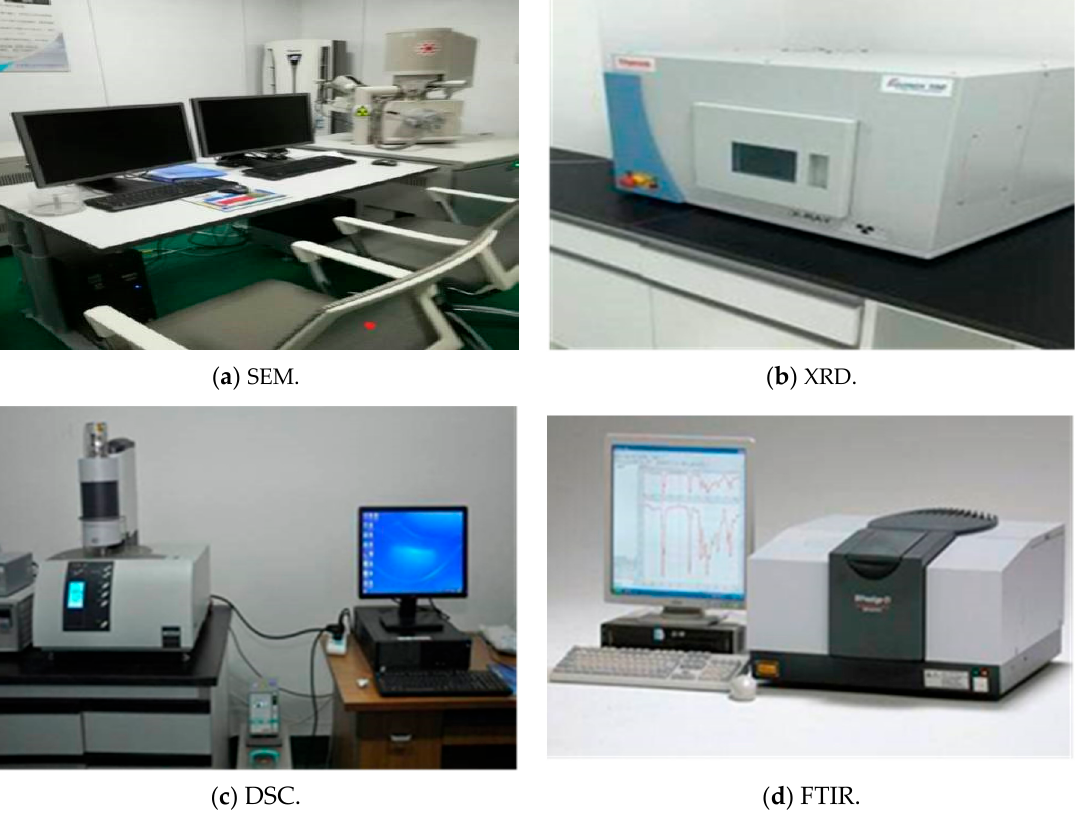
Figure 3. Corresponding equipment .